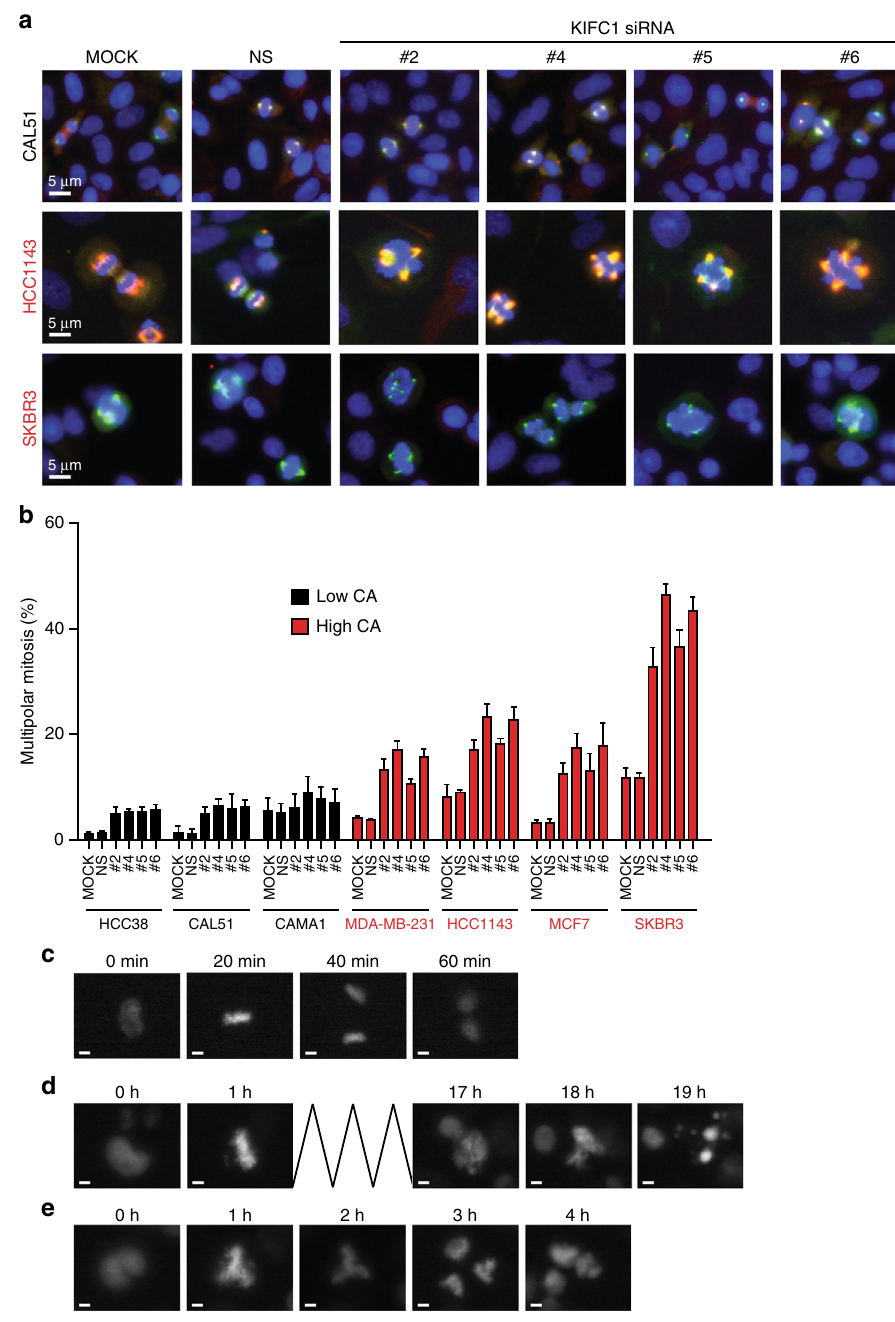
Fig. 5 Cell lines with centrosome ampli fi cation undergo multipolar mitoses followed by mitotic catastrophe in the absence of KIFC1. a Representative immuno fl uorescence images of mitotic spindles in low-CA cell line (CAL51) and high-CA cell lines (HCC1143 and SKBR3) with control or KIFC1 siRNA or mock transfection. Spindles stained with Aurora A (green) and/or Eg5 (red). Scale bar is 5 μ m. b Mean percentage of multipolar mitotic cells. Error bars represent the SEM, n = 3. c Images of time-lapse of MDA-MB-231 cells expressing NT shRNA showing a bipolar mitosis. d Images of time-lapse of MDA- MB-231 expressing KIFC1 shRNA showing prolonged mitosis and subsequent apoptosis. e . Images of MDA-MB-231 cells with inducible KIFC1 shRNA showing an abnormal multipolar mitosis. Scale bar is 5 μ